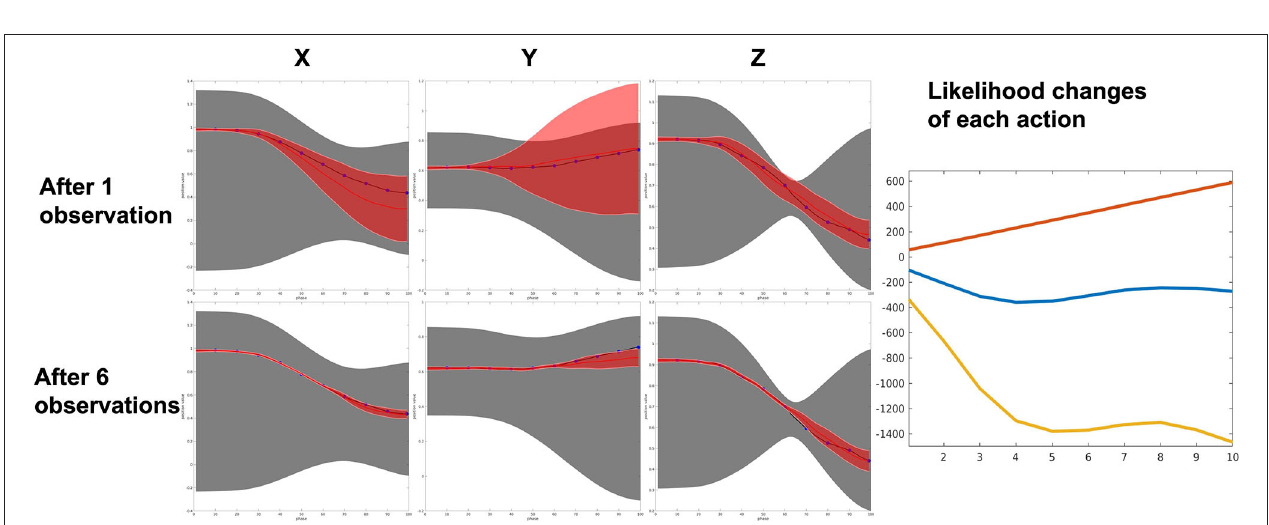
FIGURE 14 | (Top) The learned mixture of ProMP model for pick-and-place tasks: reach (red), pick (blue), place (green). (Bottom) The learned ProMP model that treat non-linearly correlated actions as a single skill type.